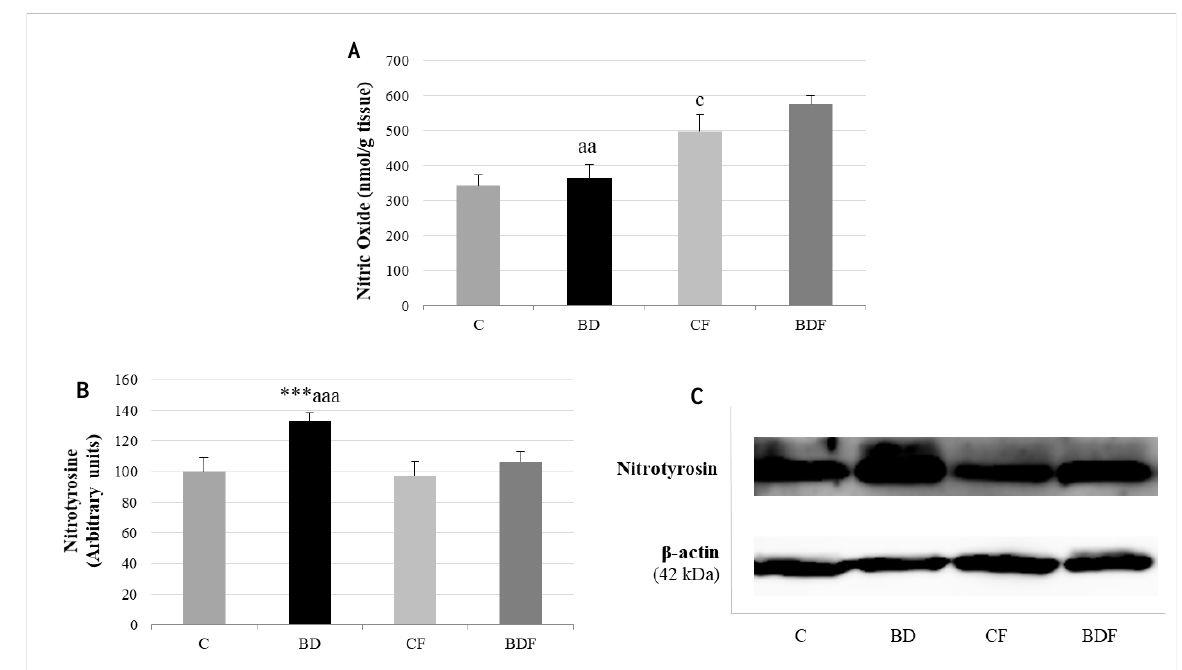
Figure 6. Nitrosative stress analysis by determining NO levels and nitrotyrosine expression in the liver of adolescent rats. Nitric oxide levels ( A ). Expression of nitrotyrosine (expressed as percent arbitrary relative units, referring to values in control animals which were defined as 100%) ( B ). Rep- resentative Western blot for the expressions of nitrotyrosine and β -actin (as load control) ( C ). The results are expressed as mean ± SEM and analysed by a multifactorial one-way ANOVA followed by Tukey’s test. The number of animals in each group is 6 and n = 12 for NO analysis or n = 6